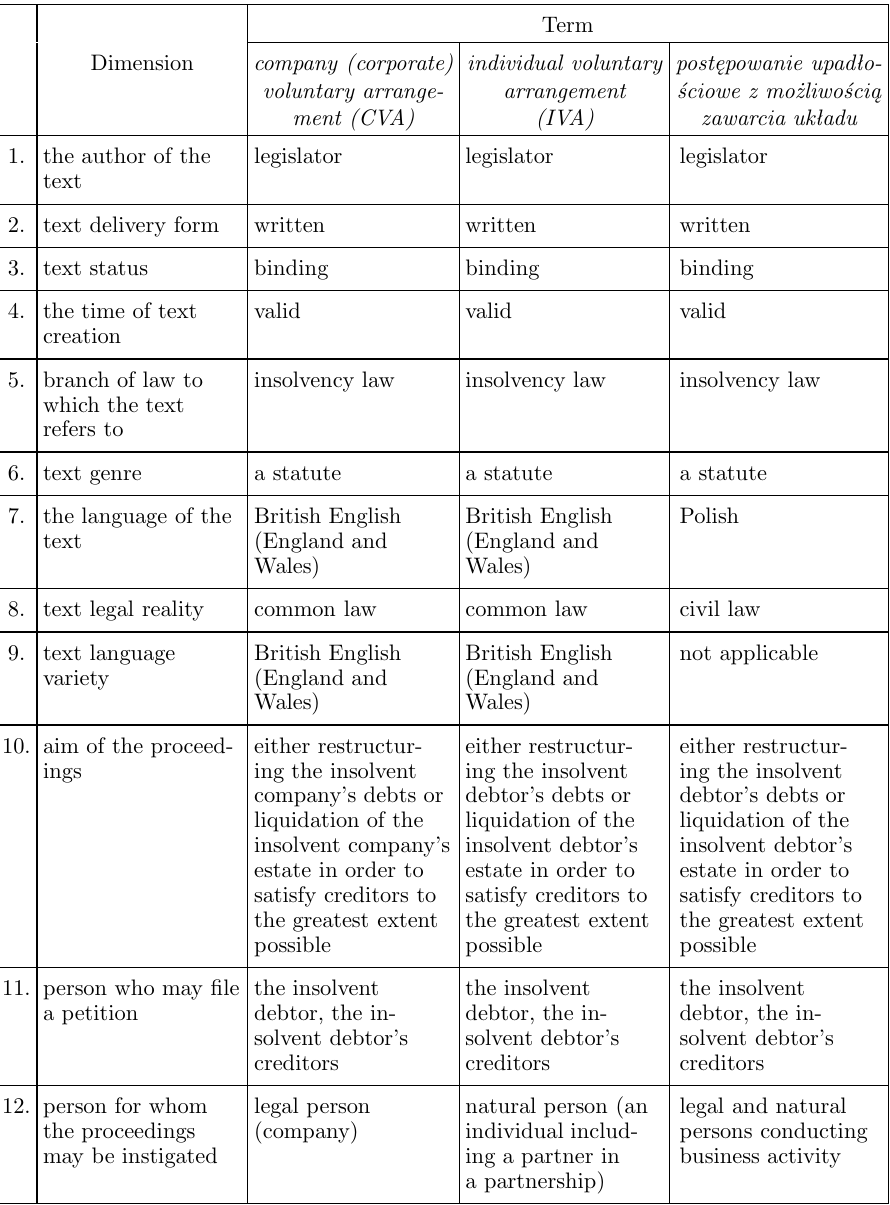
Parametrisation of the terms: company (corporate) voluntary arrangement (CVA) , individual voluntary arrangement (IVA)